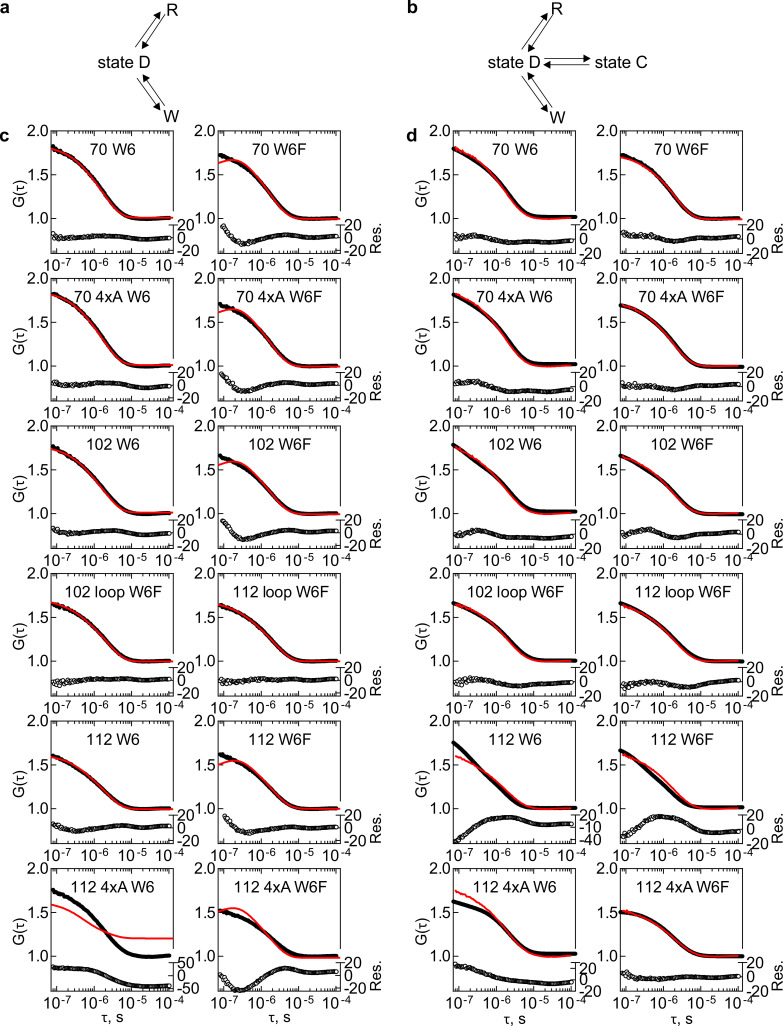
Global fitting of HemK RNC dataset B to kinetic models 2e and 3e.(a) Kinetic Model 2e: nascent chain – state C; Trp-quenched state - W, ribosome-quenched state - R. (b) Kinetic model 3e: nascent chain – state C and state D; W and R same as in a. (c) Results of global fitting of autocorrelation data to kinetic model in 2e, shown in a. Plotted on the left-hand y axis: black – measured data, red – kinetic model simulation curve, On the right-hand y axis in open circles – residual values (Res.); Each graph shows a different RNC construct as indicated. (d) Results of global fitting to kinetic model 3e, shown in b. Graph legend as in c.